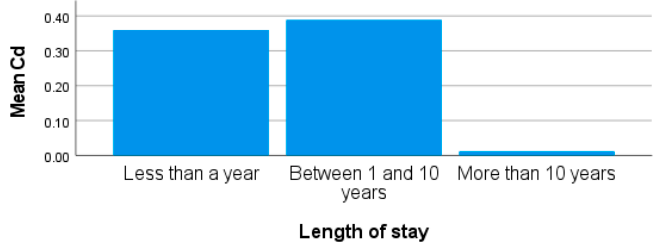
Figure 6. Showing blood Cd by length of stay in obese females living around site